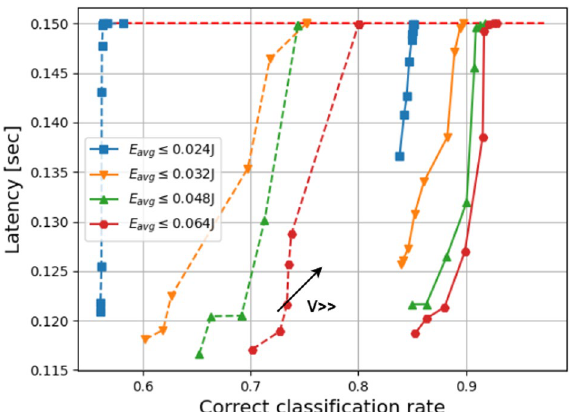
Fig. 10 Accuracy/latency trade-off. Deep-CE (solid) vs down-sampling (dashed). This figure compares the trade-off between latency and accuracy considering the deep-CE and the down-sampling compression